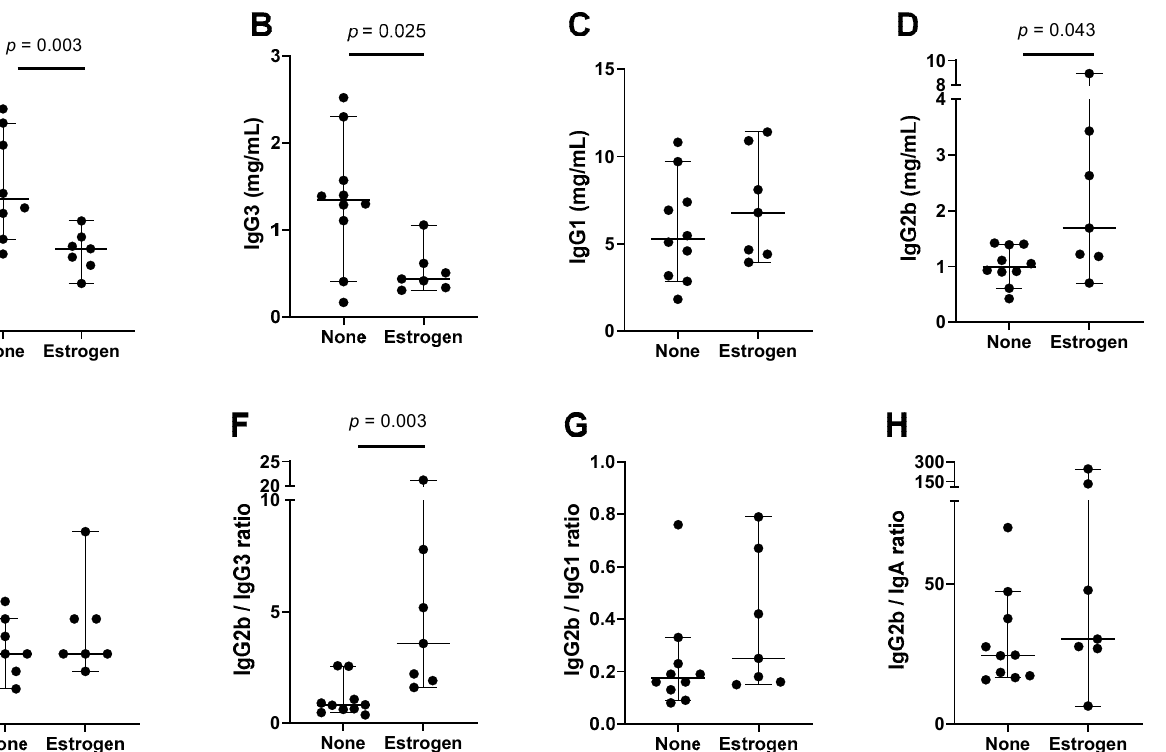
Figure 3. Estrogen supplementation influences isotype profiles in females in the context of an inflammatory insult. Each symbol represents a different mouse. All test and control animals received DNA + peptide. Groups only differed with respect to estrogen supplementation. Group medians are shown with 95% CI and p values from Mann–Whitney tests when p ≤ 0.10. Individual isotypes ( A – E ) and ratios ( F – H ) are shown. Table 3. Higher IgG2b in estrogen-supplemented compared to unsupplemented mice.